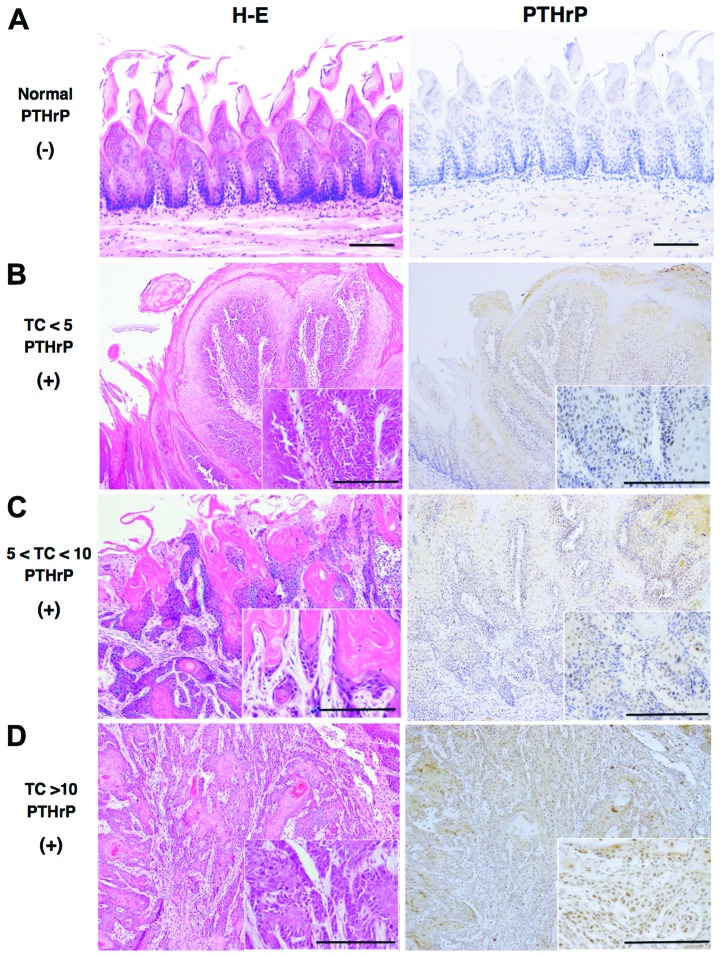
Hematoxylin and eosin (H&E) staining (left) and anti-PTHrP immunohistochemistry (right) of F1 normal rat tongue (A) and tongue cancers (TC) (<5 mm in diameter (TC <5) for H&E and PTHrP-positive (+) (B); TC of 5–10 mm (TC 5–10) for H&E and PTHrP (+) (C); TC >10 mm (TC >10) for H&E and PTHrP (+) (D). The PTHrP-(+) tissue shows a positive signal in the cytoplasm and nucleus of many cancer cells. Scale bars, 200 μm.